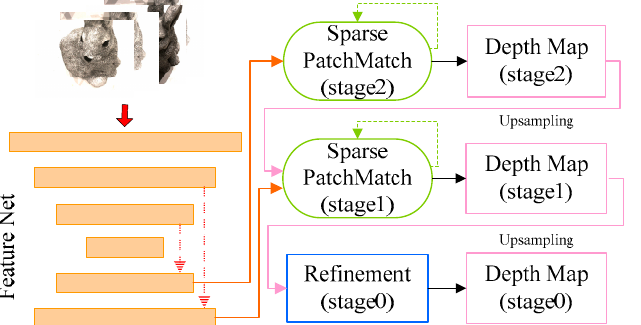
Figure 1. The overall framework of SGT‑PatchMatchNet. Our framework mainly consists of a feature extraction network, two subnetworks, and an optimization network.